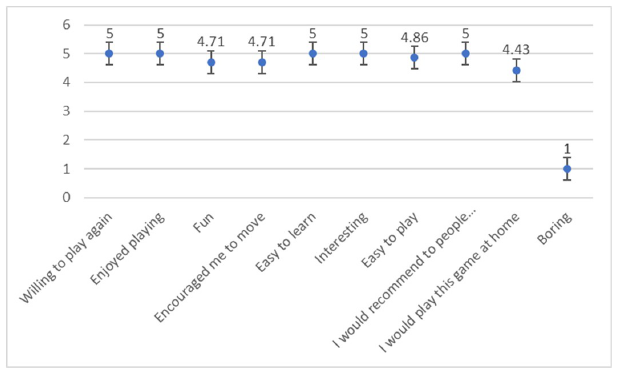
Figure 10. Participant ratings of gameplay experience (1 = strongly disagree, 2 = disagree, 3 = natural, 4 = agree, 5 = strongly agree).